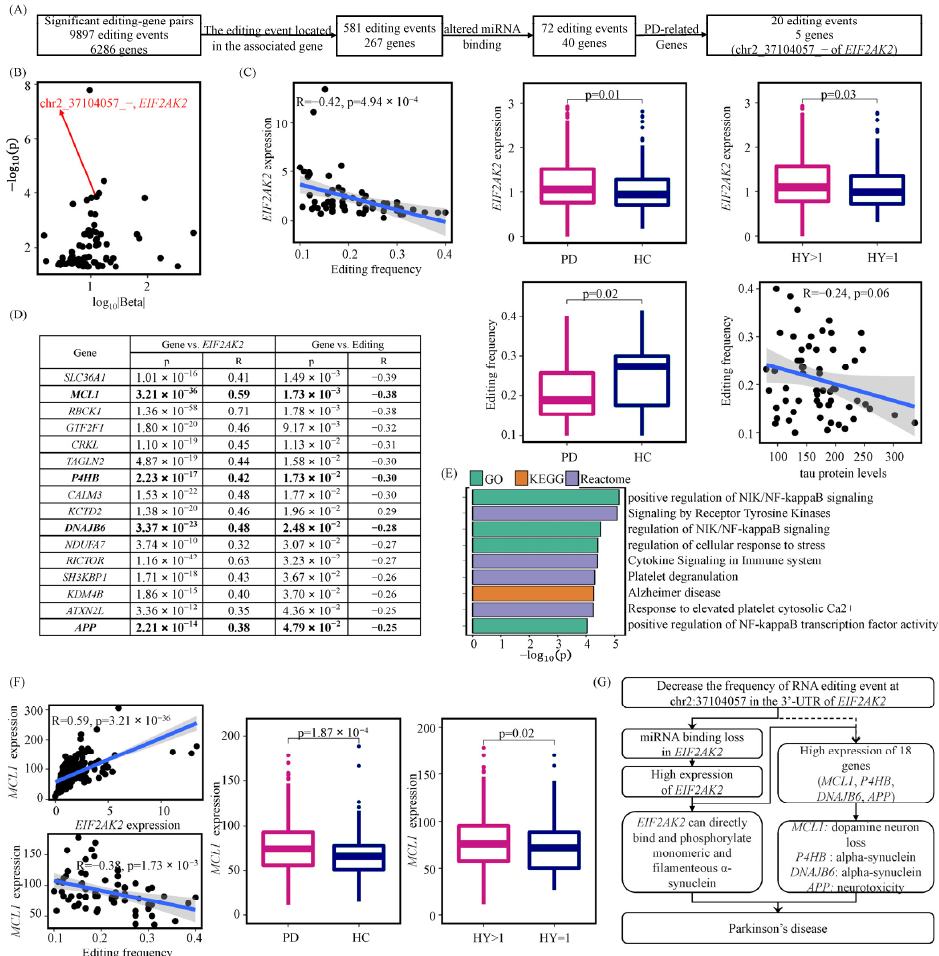
Figure 3. A-to-I RNA editing events may alter miRNA regulations of their host genes. ( A ) Analysis procedures to uncover one mechanism of the associations between RNA editing events and their host genes. ( B ) The scatter plot shows the RNA editing events, which may alter miRNA regulations of their host genes. The editing example in EIF2AK2 is highlighted. ( C ) This RNA editing event is negatively associated with EIF2AK2 expression. EIF2AK2 is overexpressed in PD and in more severe PD samples. The RNA editing event shows lower editing frequencies in PD samples and negative associations with tau protein levels. ( D ) The 16 EIF2AK2 -interacted genes are significantly associated with EIF2AK2 and the RNA editing event. Genes known to be implicated in PD are in bold. ( E ) The 16 genes are enriched in neurodegeneration-related processes by Metascape. ( F ) Of them, MCL1 is overexpressed in PD and in more severe PD samples. ( G ) The analyses above may uncover the potential effects of this RNA editing event on five PD-related